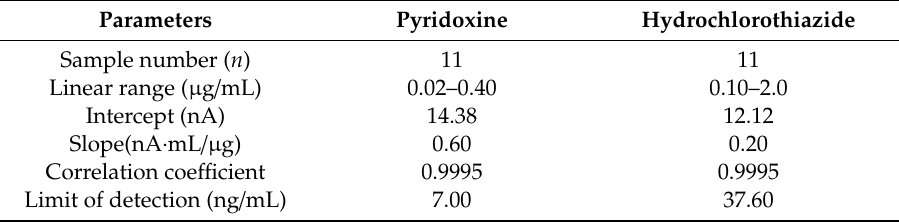
Table 1. The parameters of linear equation obtained by the proposed method.